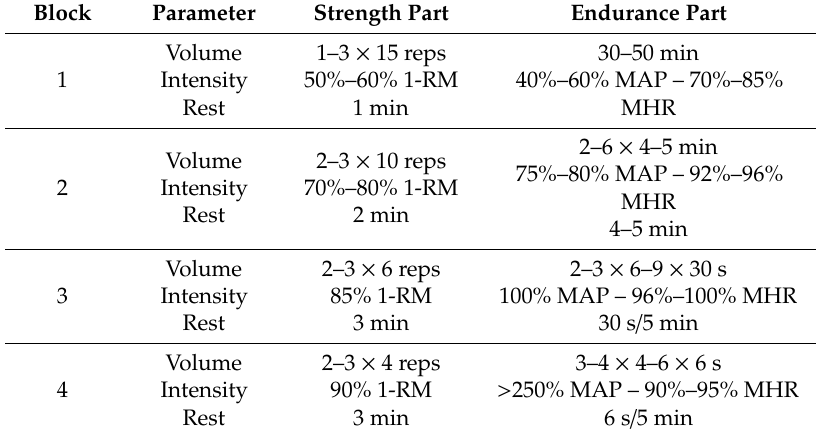
Table 1. Training plan of the institutional physical activity program for physically inactive students. Block Parameter Strength Part Endurance Part Volume 1 Intensity